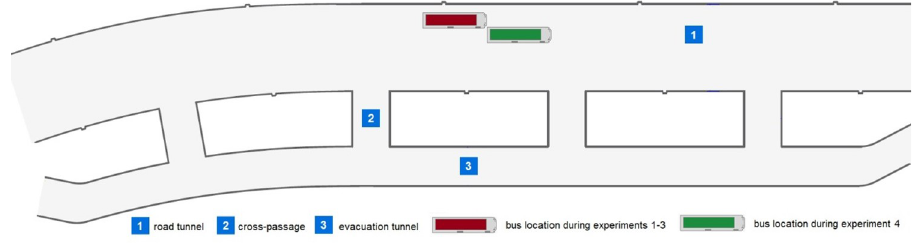
Fig 1. Bus location during experiments 1–4 in Emilia tunnel in Laliki.